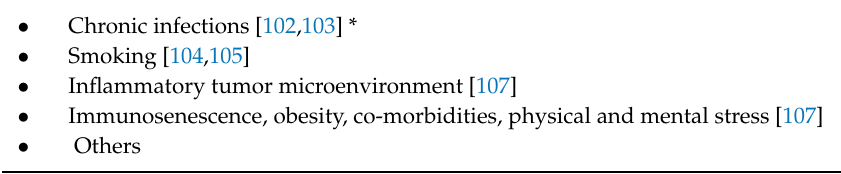
Table 2. Host-associated factors which may restrict the efficacy of immunogenic cell